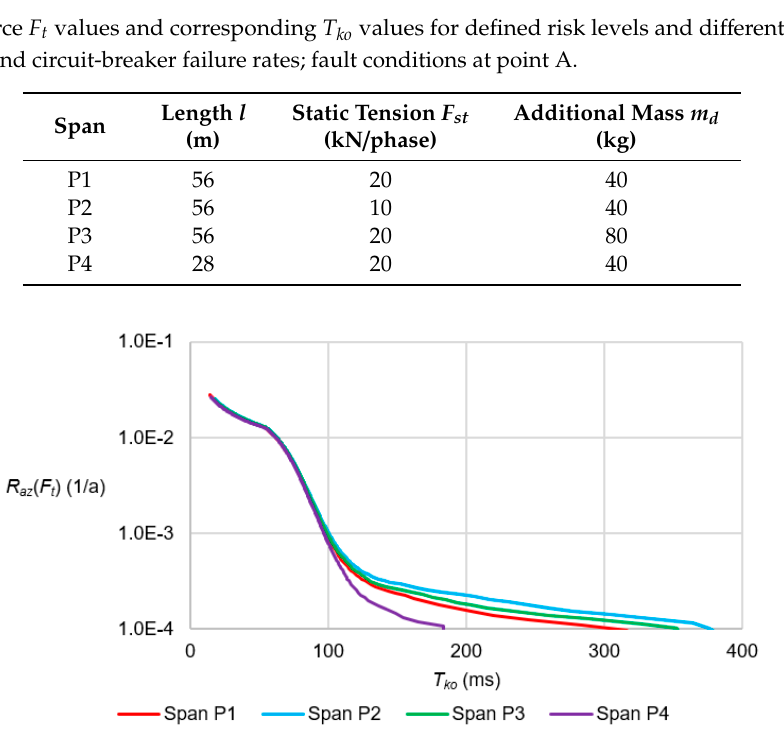
Figure 17. Risk of exceeding force F t versus T ko values for short circuit current of 40 kA for four different spans.